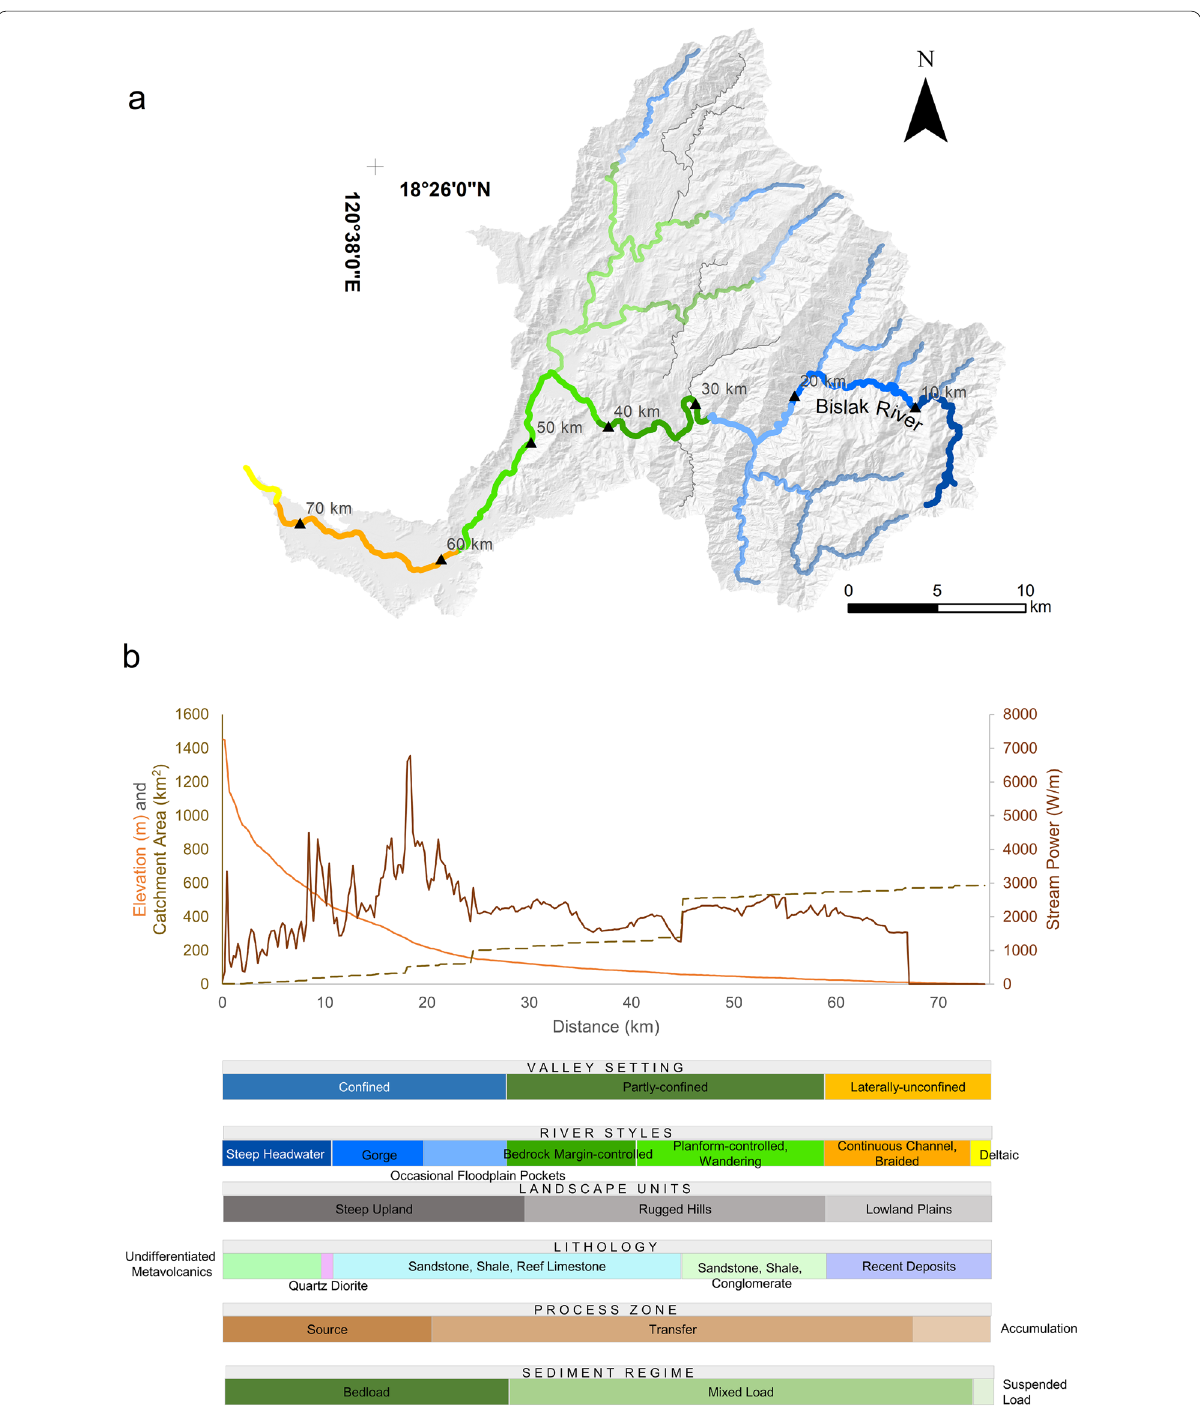
Fig. 5 a Distribution of Pattern 1 rivers in the Bislak Catchment. The trunk stream (Bislak River) is represented by thicker lines with markers to show the distance from the channel head to the outlet. Pattern 2–5 rivers are shown in grey. b Stream power against longitudinal profile-catchment area for the Bislak River (annotated with boundary